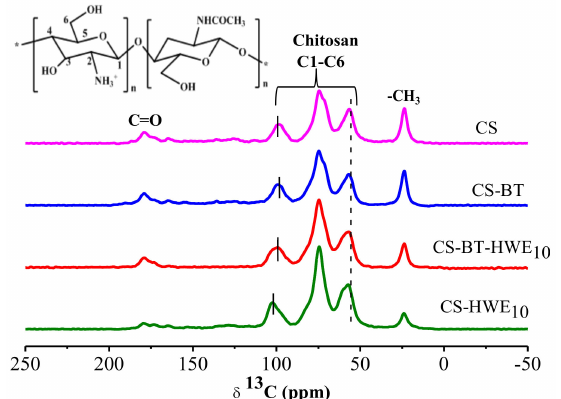
Figure 8. 13 C-NMR spectra of composite films prepared from chitosan, BT, and hot water wood